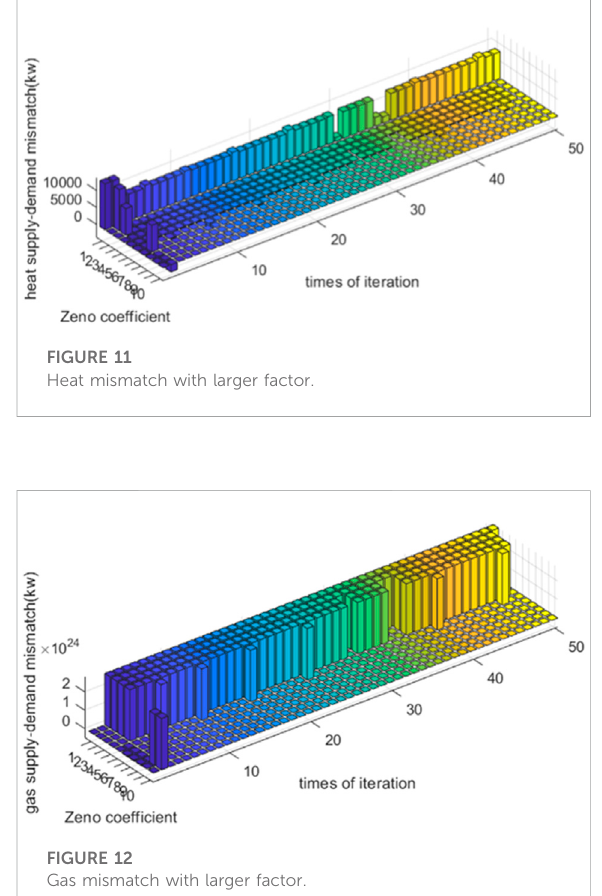
FIGURE 12 Gas mismatch with larger factor.